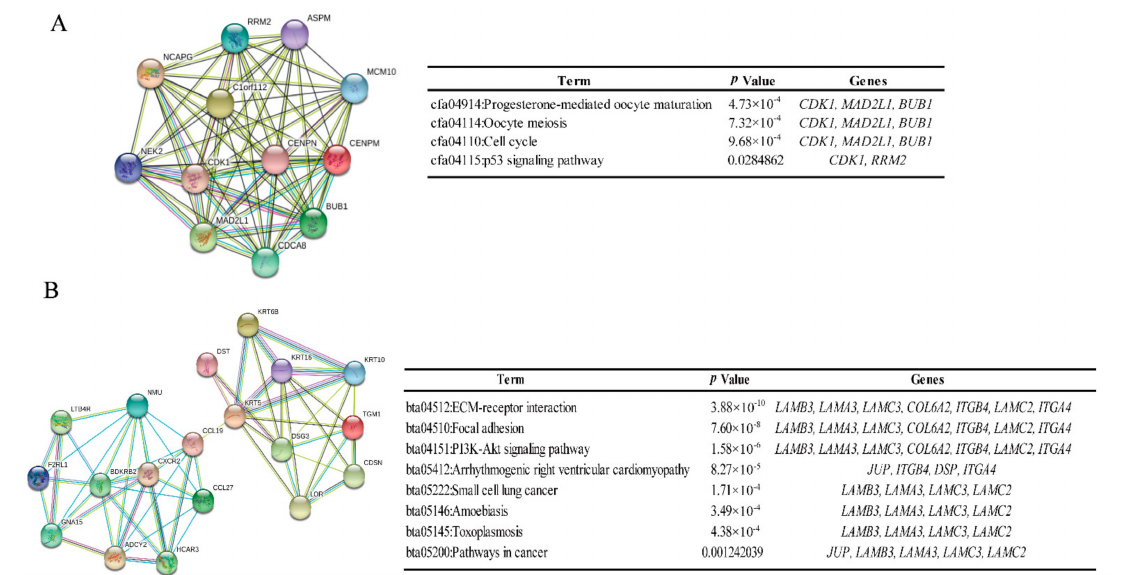
Figure 3. Top two modules from the PPI network. ( A ) Module 1 and the enriched pathways of module 1. ( B ) Module 2 and the enriched pathways of module